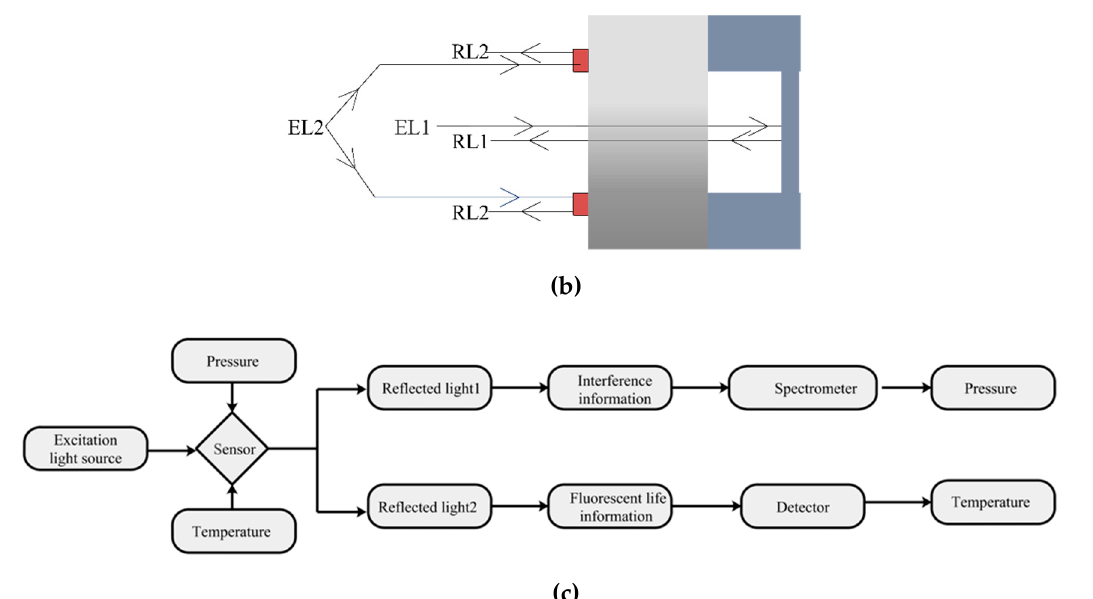
Figure 1. Schematic diagram of ( a ) configuration; ( b ) optical path; ( c ) working principle of the hybrid fiber-optic F–P sensor.